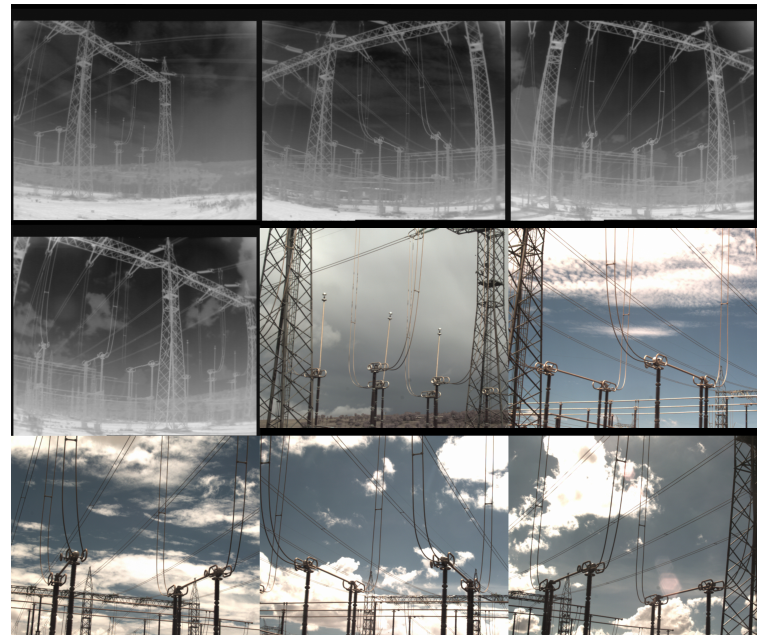
Figure 11. Thermal and RGB image dataset